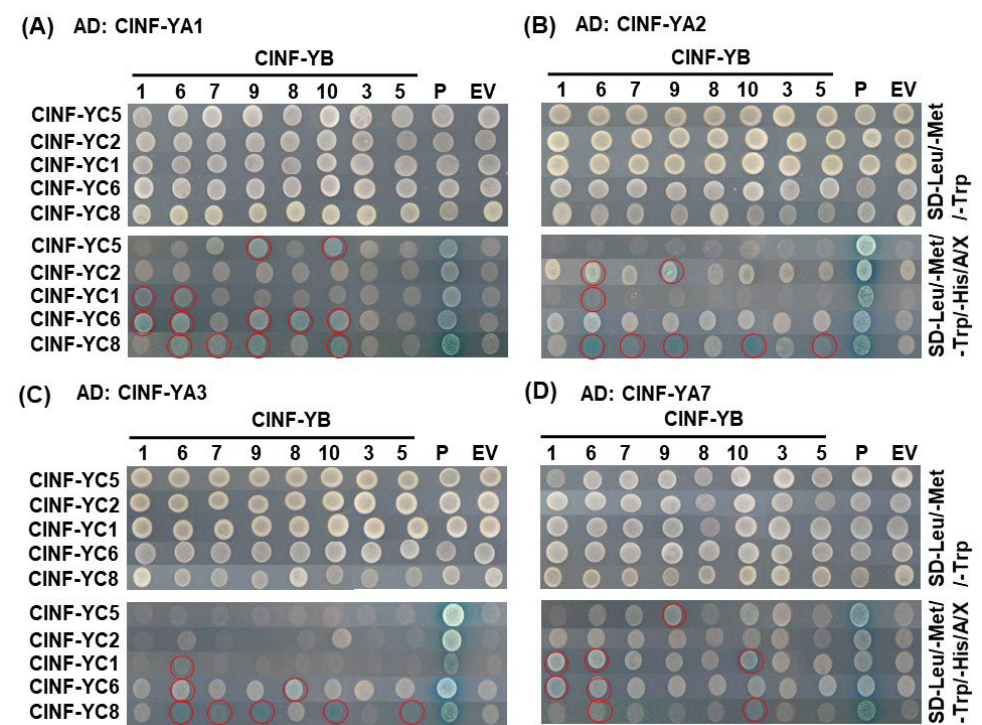
Figure 6. Assembly of the ClNF-Y complexes by the interactions of ClNF-YAs, ClNF-YBs, and ClNF-YCs in Y3H assays. ClNF-YAs were cloned into pGADT7 to fuse with the GAL4 activation domain, while paired combinations of ClNF-YBs and ClNF-YCs were cloned into pBridge to fuse with the GAL4 DNA-binding domain. Growth of yeasts co-transformed with indicated pGADT7 and pBridge vectors were grown on SD-Leu/-Met/-Trp noninteraction selective medium or on SD-Leu/-Met/-Trp/-His/AbA/X- α -gal interaction selective medium. Experiments were performed three times with similar results. Putative ClNF-Y complexes are indicated with open red circles.